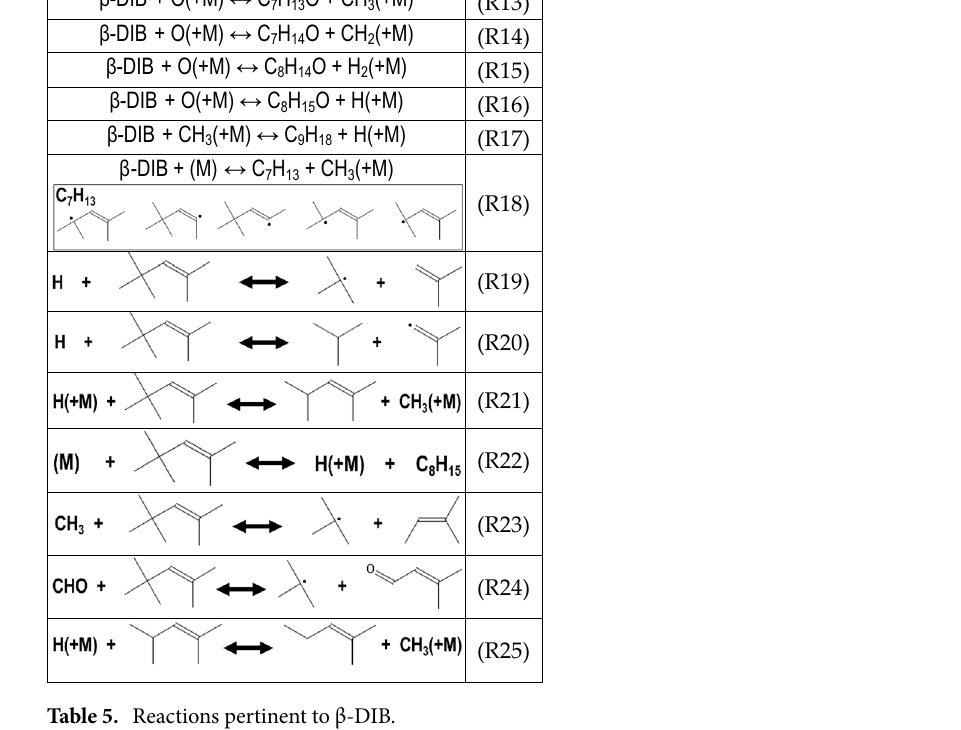
Table 5. Reactions pertinent to